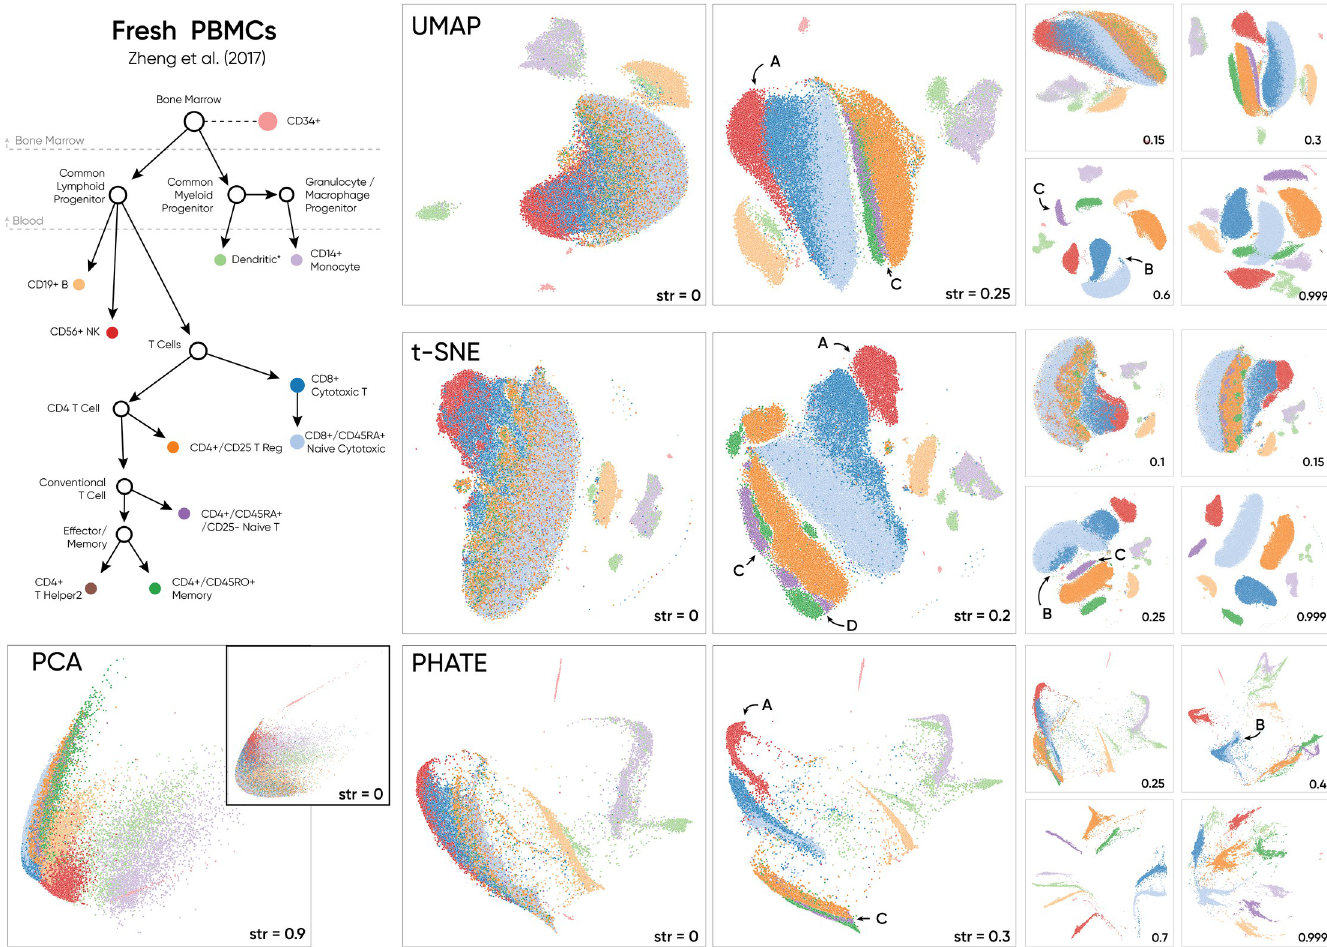
Fig 2. For this dataset, Haisu applies an input hierarchy based on cell function and lineage to guide the identification of sub-clusters. We display the effect of our method on popular nonlinear DR approaches and PCA at multiple ‘strength’ values (str), a tunable factor between 0 and (up to) 1 to control the strength of our hierarchical distancing function. Compared to raw NLDR (str = 0), Haisu reveals sub-clusters of T cells and better expresses the subtle relationship between datapoints in each method.